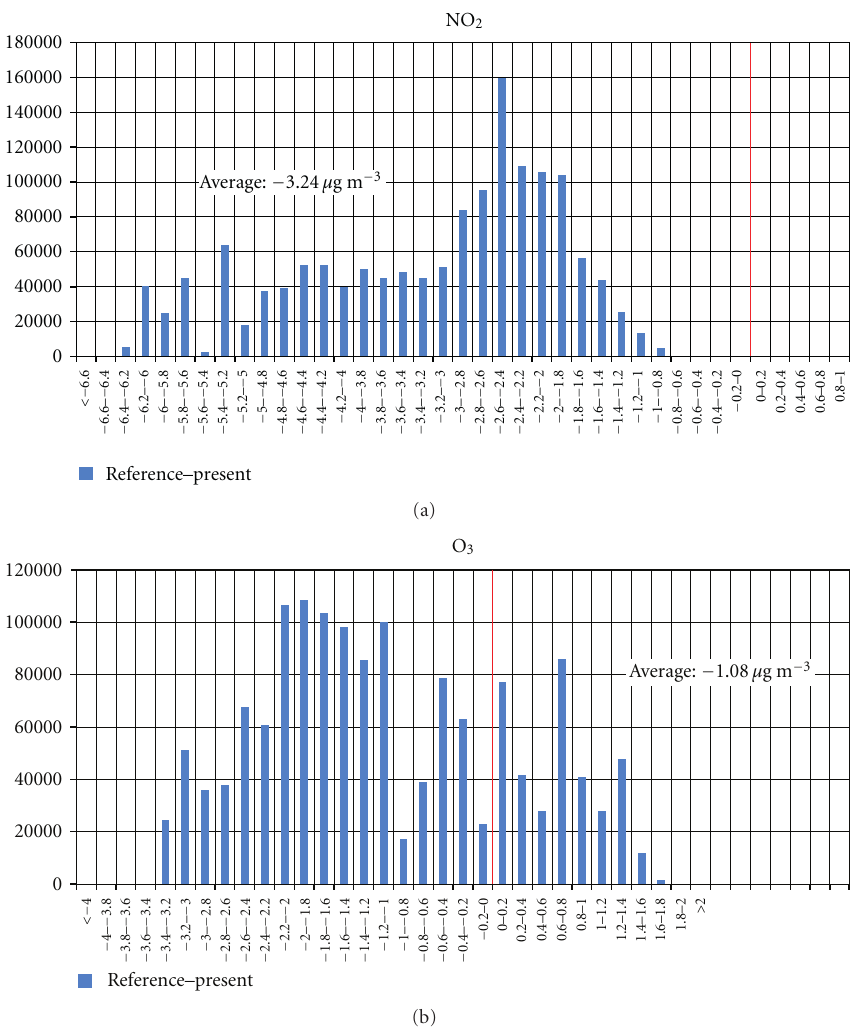
Figure 8: Di ff erences in the number of inhabitants exposed to NO 2 (a) and O 3 (b) concentration levels “Reference” (2030)—“Present” (2010). The red vertical line indicates zero di ff erence. All simulations made with ECHAM5 A1B-r3 and RCP4.5 time varying emissions. Unit x axis: µ gm − 3